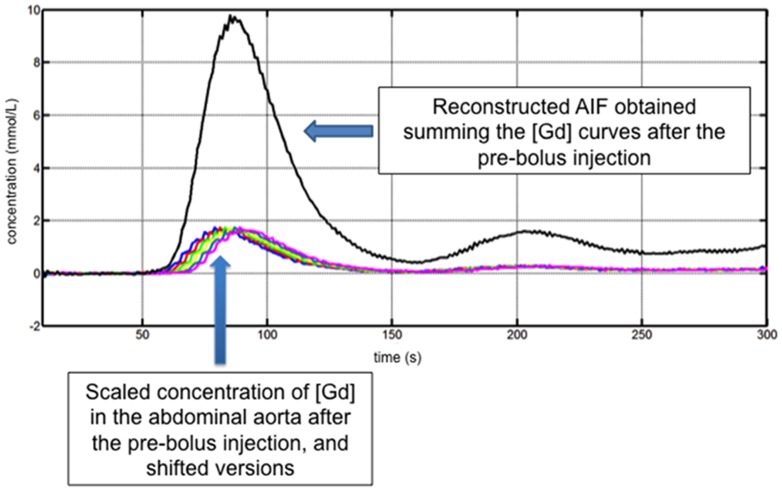
AIF reconstruction using measured gadolinium concentration in the abdominal aorta after pre-bolus injection in a 52 year-old male patient with HCV.The reconstructed AIF consists of the addition of scaled time-shifted versions of the response to low-dose pre-bolus injection of contrast agent. The concentration curve in the abdominal aorta displays rapid oscillations superimposed to the expected signal shape due to in-flow effects, which are minimized by the selection of the small flip angle and a coronal oblique acquisition that contains the abdominal aorta.